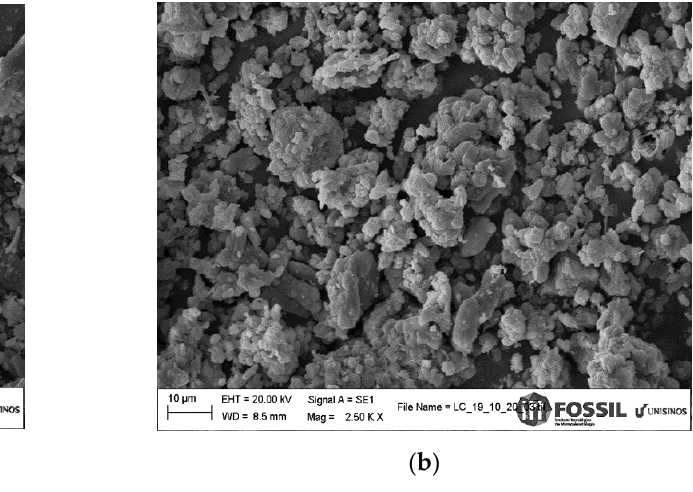
Figure 3. Industrial waste morphology: ( a ) ORPS and ( b ) CCS.